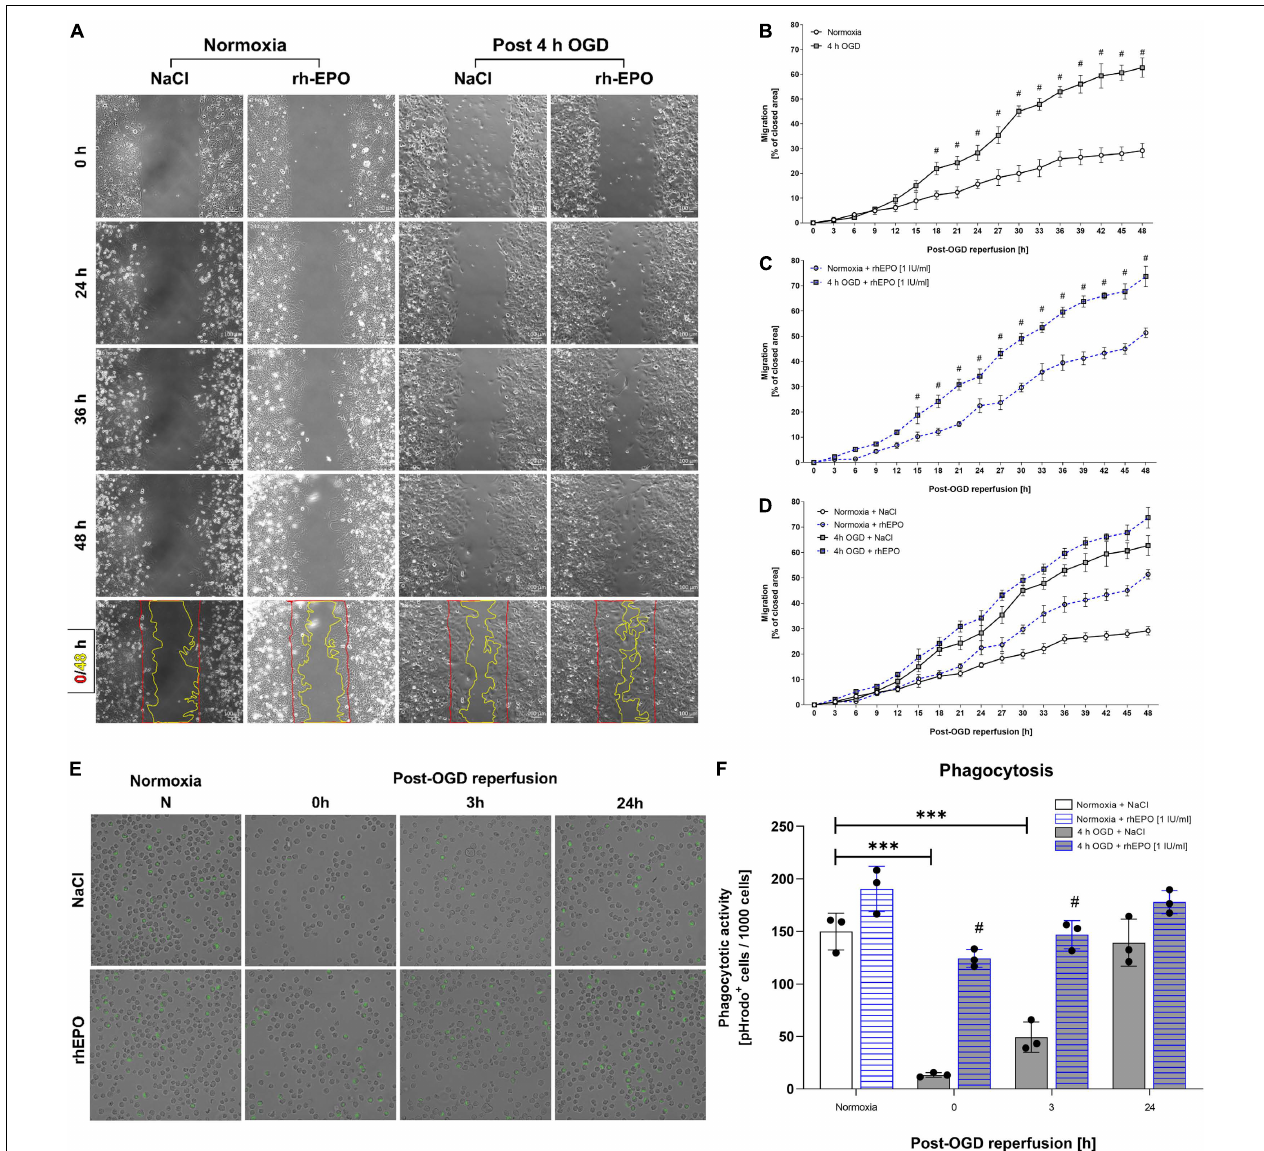
FIGURE 4 | Administration of recombinant human erythropoietin (rhEPO) increases migration and restores OGD-dependent decrease of phagocytic activity in HMC-3 microglial cells. HMC-3 microglial cells were subjected to 4 h of OGD treated with a single-dose of rhEPO [1 IU/ml] or NaCl. Migration ability was assessed using a zone exclusion assay. (A) Representative images of HMC-3 migration over a period of 48 h after stimulation. Quantification of HMC-3 migration treated either with (B) NaCl or (C) rhEPO [1 U/ml] after 4 h of OGD or corresponding normoxia control. (D) Overview of migration of both NaCl and rhEPO [1 U/ml] treated cells. Intergroup differences were tested by multiple t -tests followed by two-stage set-up method of Benjamini, Krieger, and Yekutieli. Data are presented as means ± SD of 3 individual experiments with 3 technical replicates in each experiment. # p < 0.05 compared to normoxia control. (E) Representative images of phagocytic activity of HMC-3 after 4 h OGD using pHrodoTM Green E. coli Bioparticles.TM (F) Quantification of phagocytic activity. pHrodoTM Green E. coli BioparticlesTM positive cells per 1,000 counted cells were quantified in each experiment. Intergroup differences were tested by ANOVA two-way followed by Tukey post hoc test (multiple comparison). Bars represent means ± SD of 3 individual experiments with three technical replicates in each experiment, individual data points are shown. ∗ p < 0.05, ∗∗ p < 0.01, ∗∗∗ p < 0.001 between groups, # p < 0.05 compared to vehicle